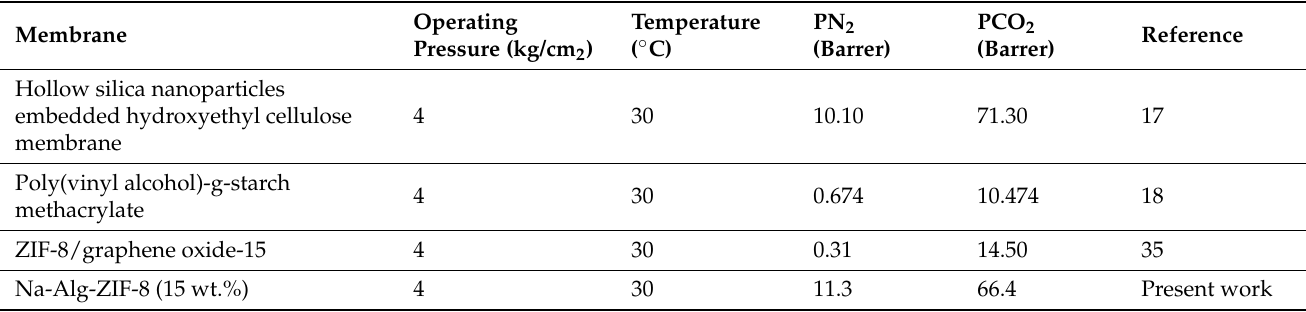
Table 2. Comparison of the present work to the literature in terms of